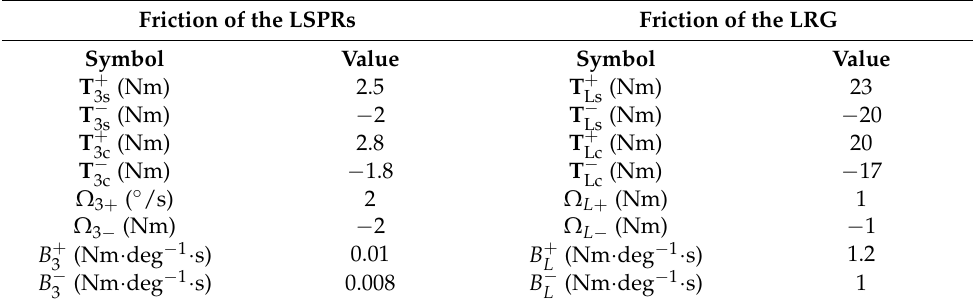
Table 2. Friction model parameter